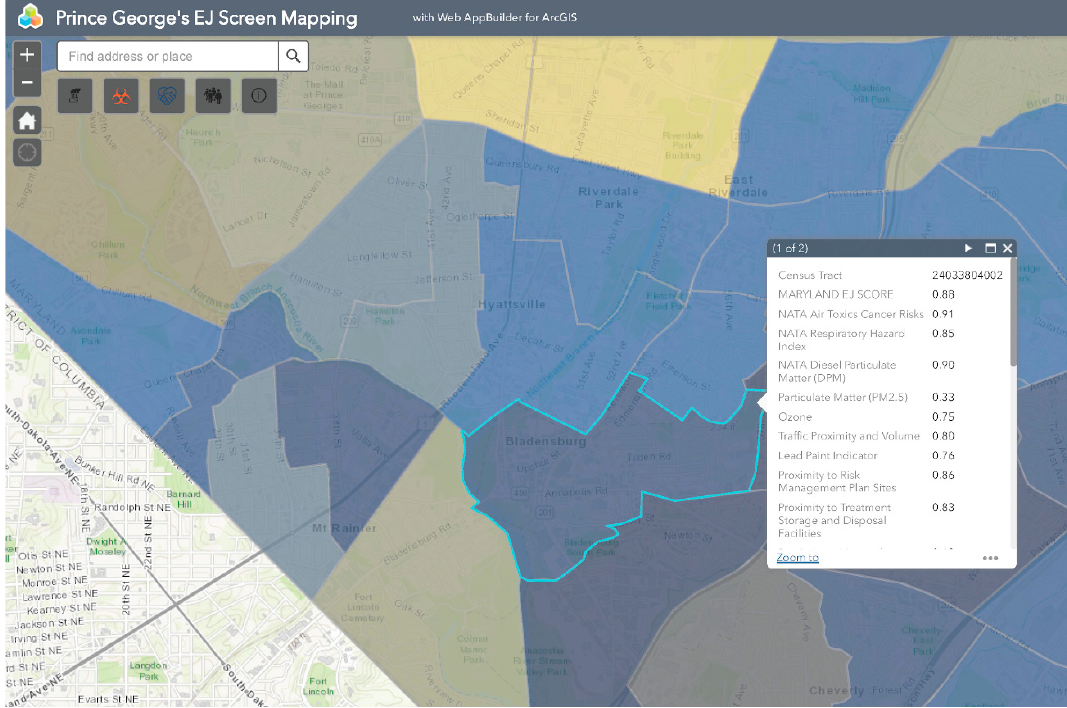
Figure 6. NATA air toxics layer overlaid with percent non-White in Bladensburg.